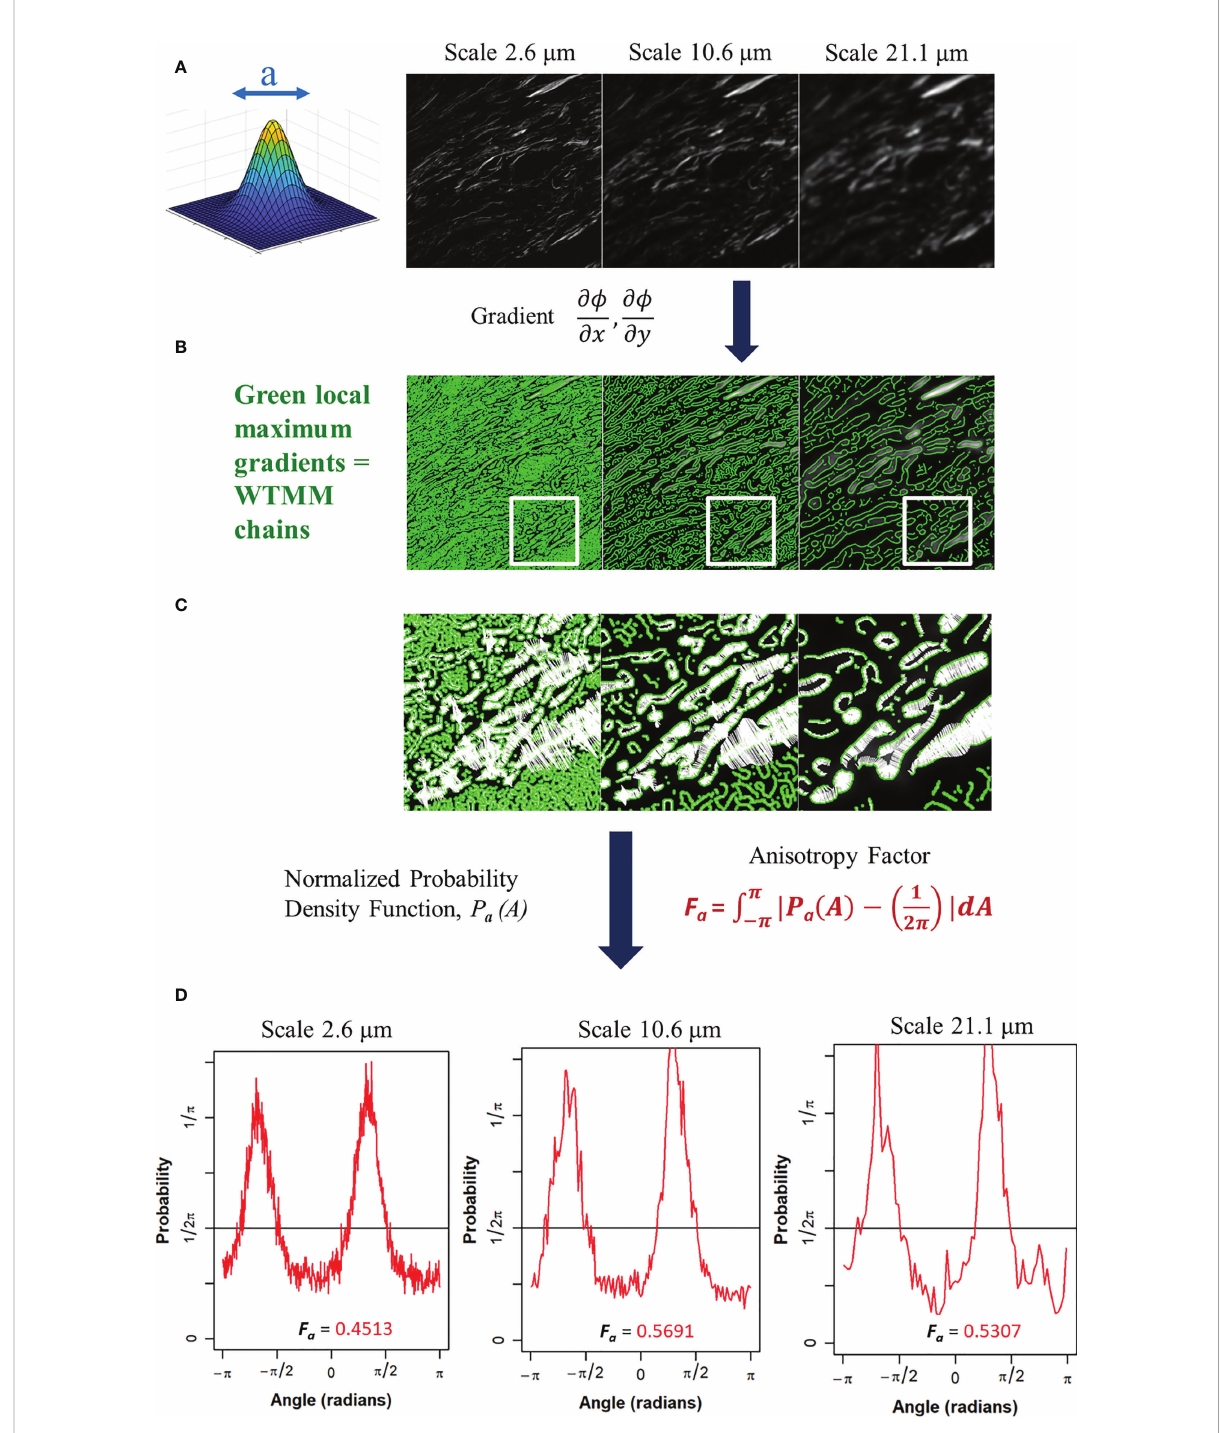
FIGURE 2 (A) Gaussian wavelet convolved SHG image at 3 representative wavelet size scales. (B) Maxima chains at 3 representative wavelet scales shown in green. (C) Zoomed inserts from white outlined area in panel B at 3 representative wavelet size scales to identify WTMM vectors (white arrows) showing magnitude and direction of local gradients of the maximum image density fl uctuations. (D) Probability density functions (PDF), shown in red, of 3 representative wavelet scales generated from angles of local gradient vectors with the theoretical isotropic 1/2pi line shown in black. The anisotropy factor, Fa (Eq. 4), is shown for each